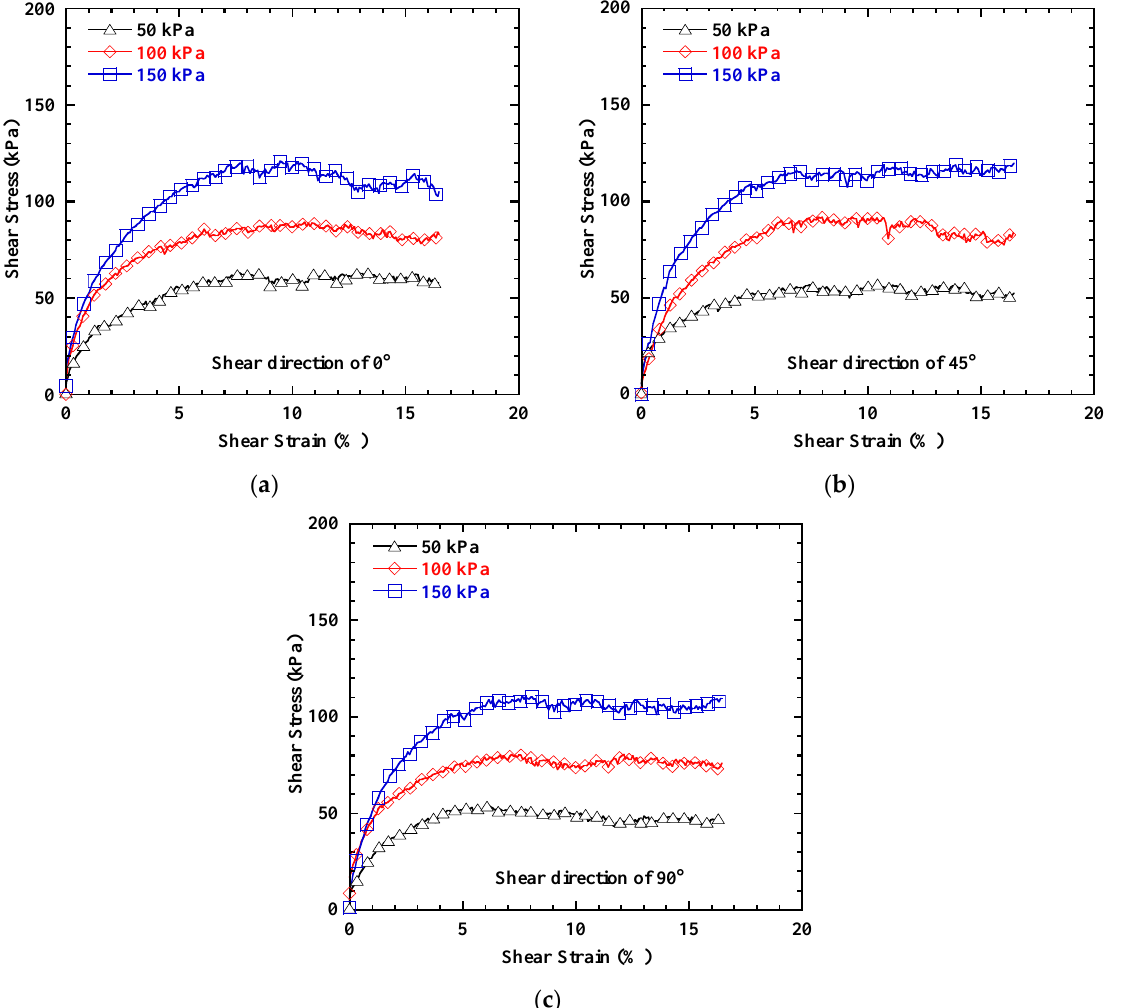
Figure 10. Shear stress–strain curves for coarse sand–triaxial geogrid (TX150) interfaces. ( a ) Shear direction of 0°, ( b ) shear direction of 45°, ( c ) shear direction of 90°.